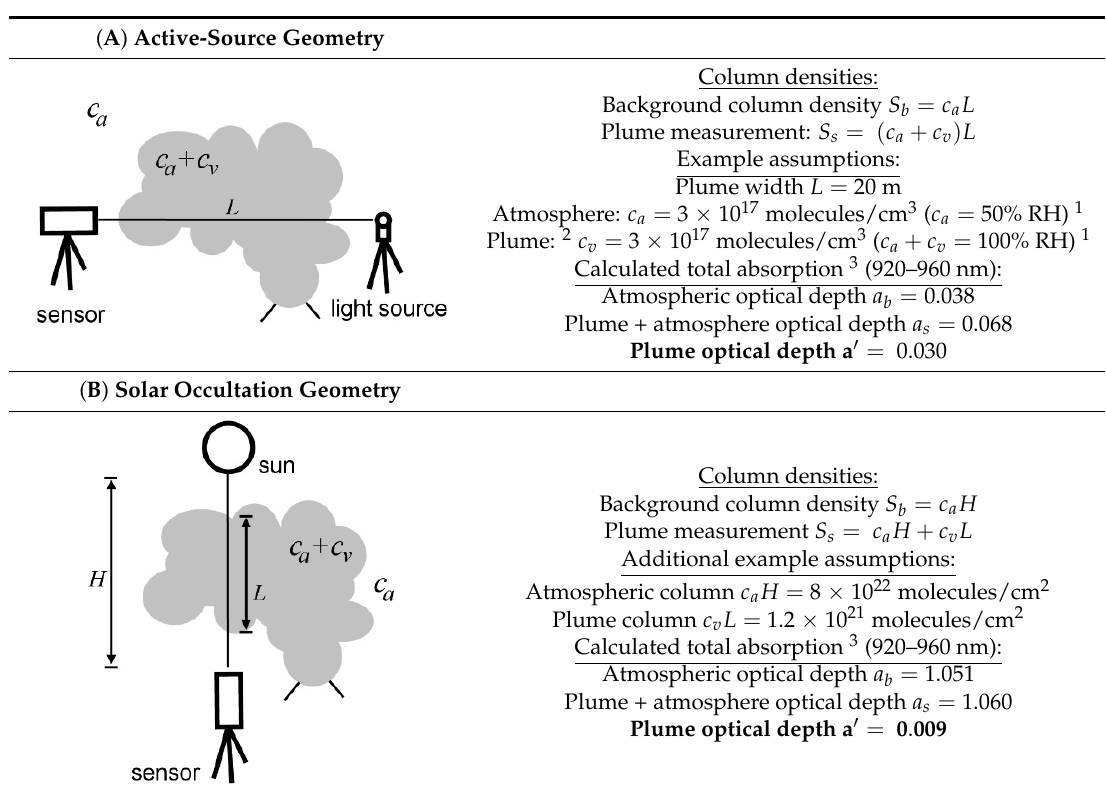
Table 1. Overview of discussed geometries for remote sensing of water vapor in volcanic plumes.